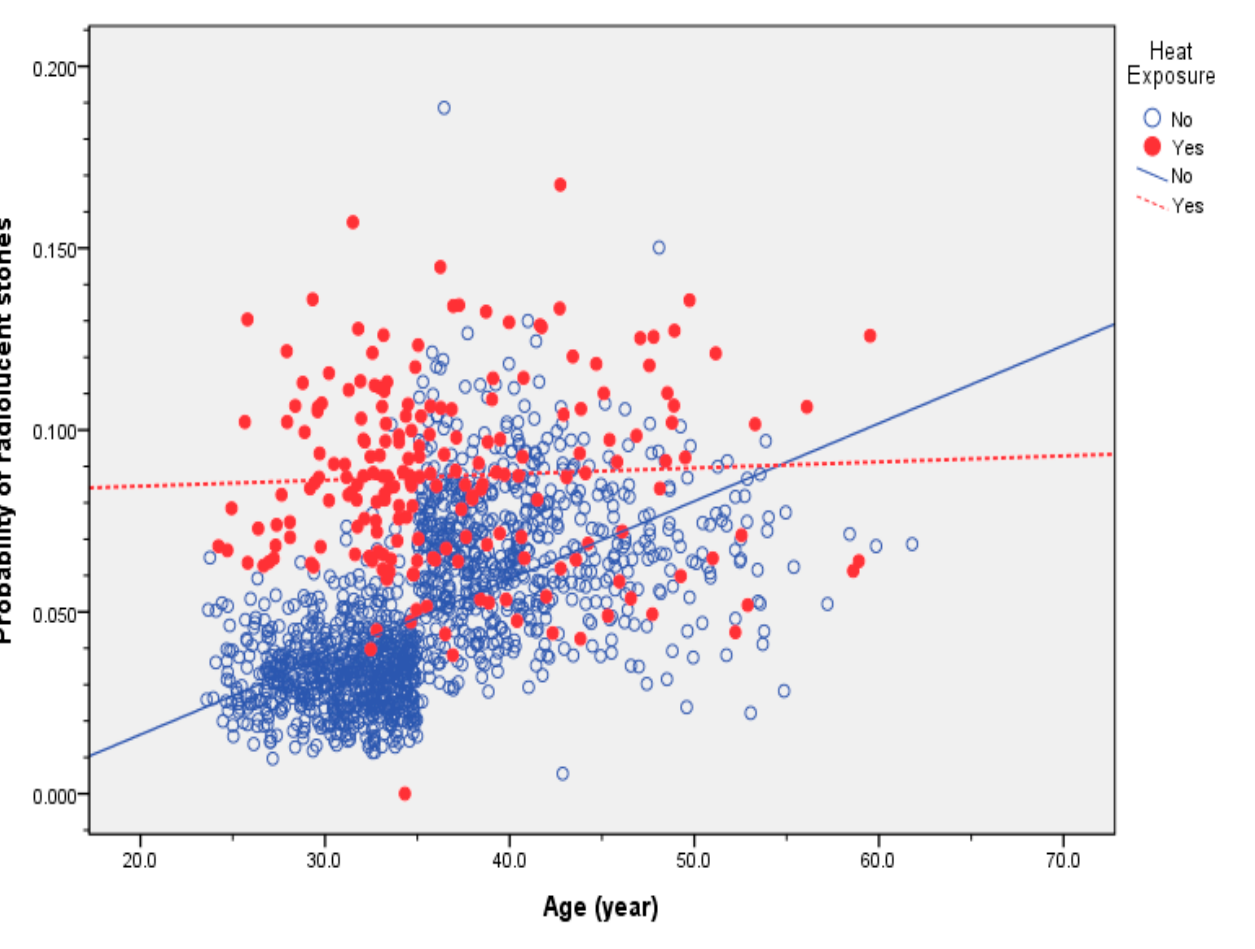
Figure 1. Correlations between the probability of radiolucent stones and age in steel workers with and without heat